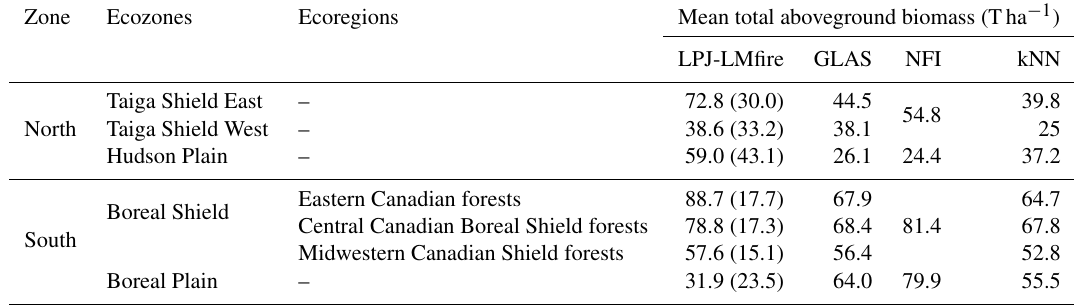
Table 2. LPJ-LMfire vs. Margolis et al. (2015) mean total aboveground biomass estimates (with standard deviations) between 2000 and 2006 across five ecozones in eastern boreal Canada. The Boreal Shield ecozone was divided into three ecoregions (ecozone subdivisions) for